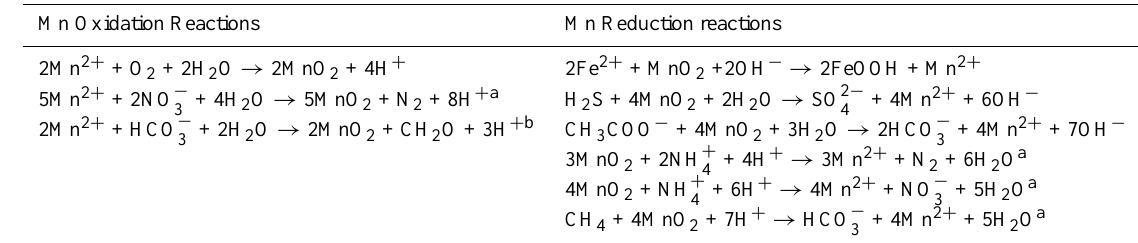
Table 1. Reactions controlling Mn cycling in stratified water